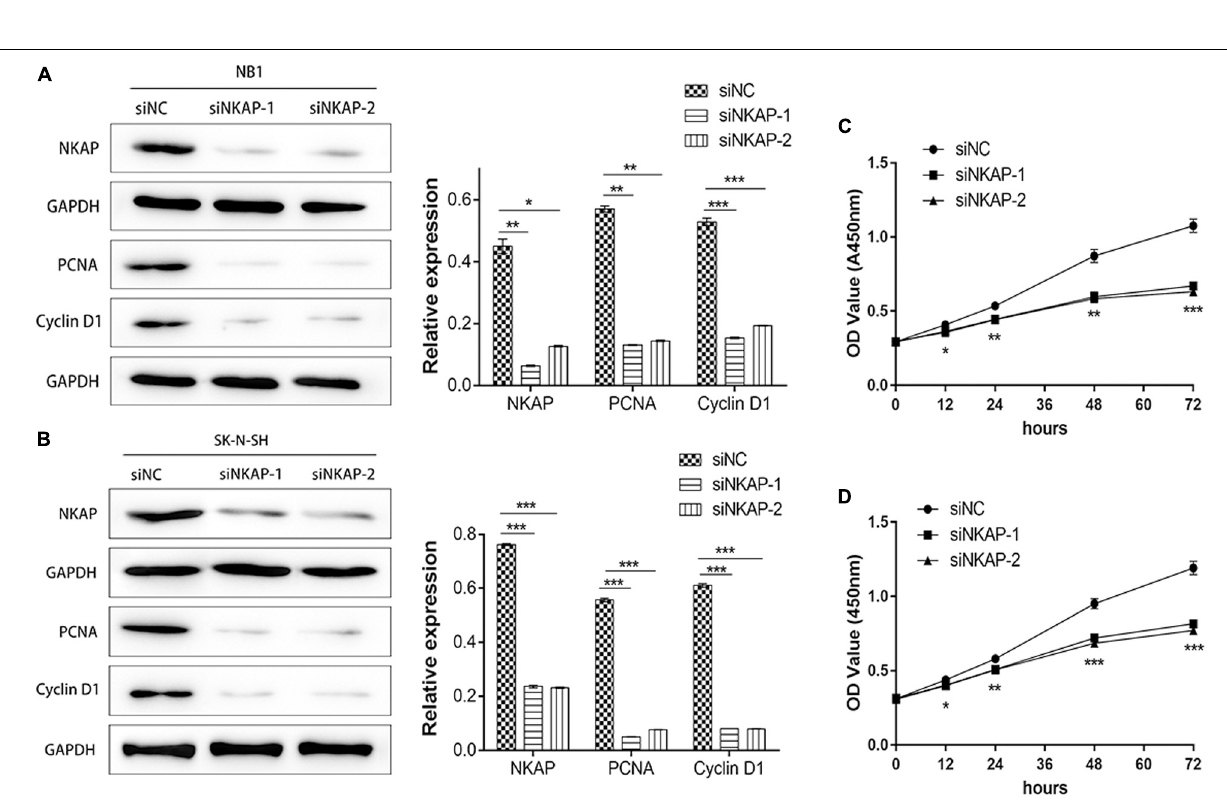
Frontiers in Cell and Developmental Biology |